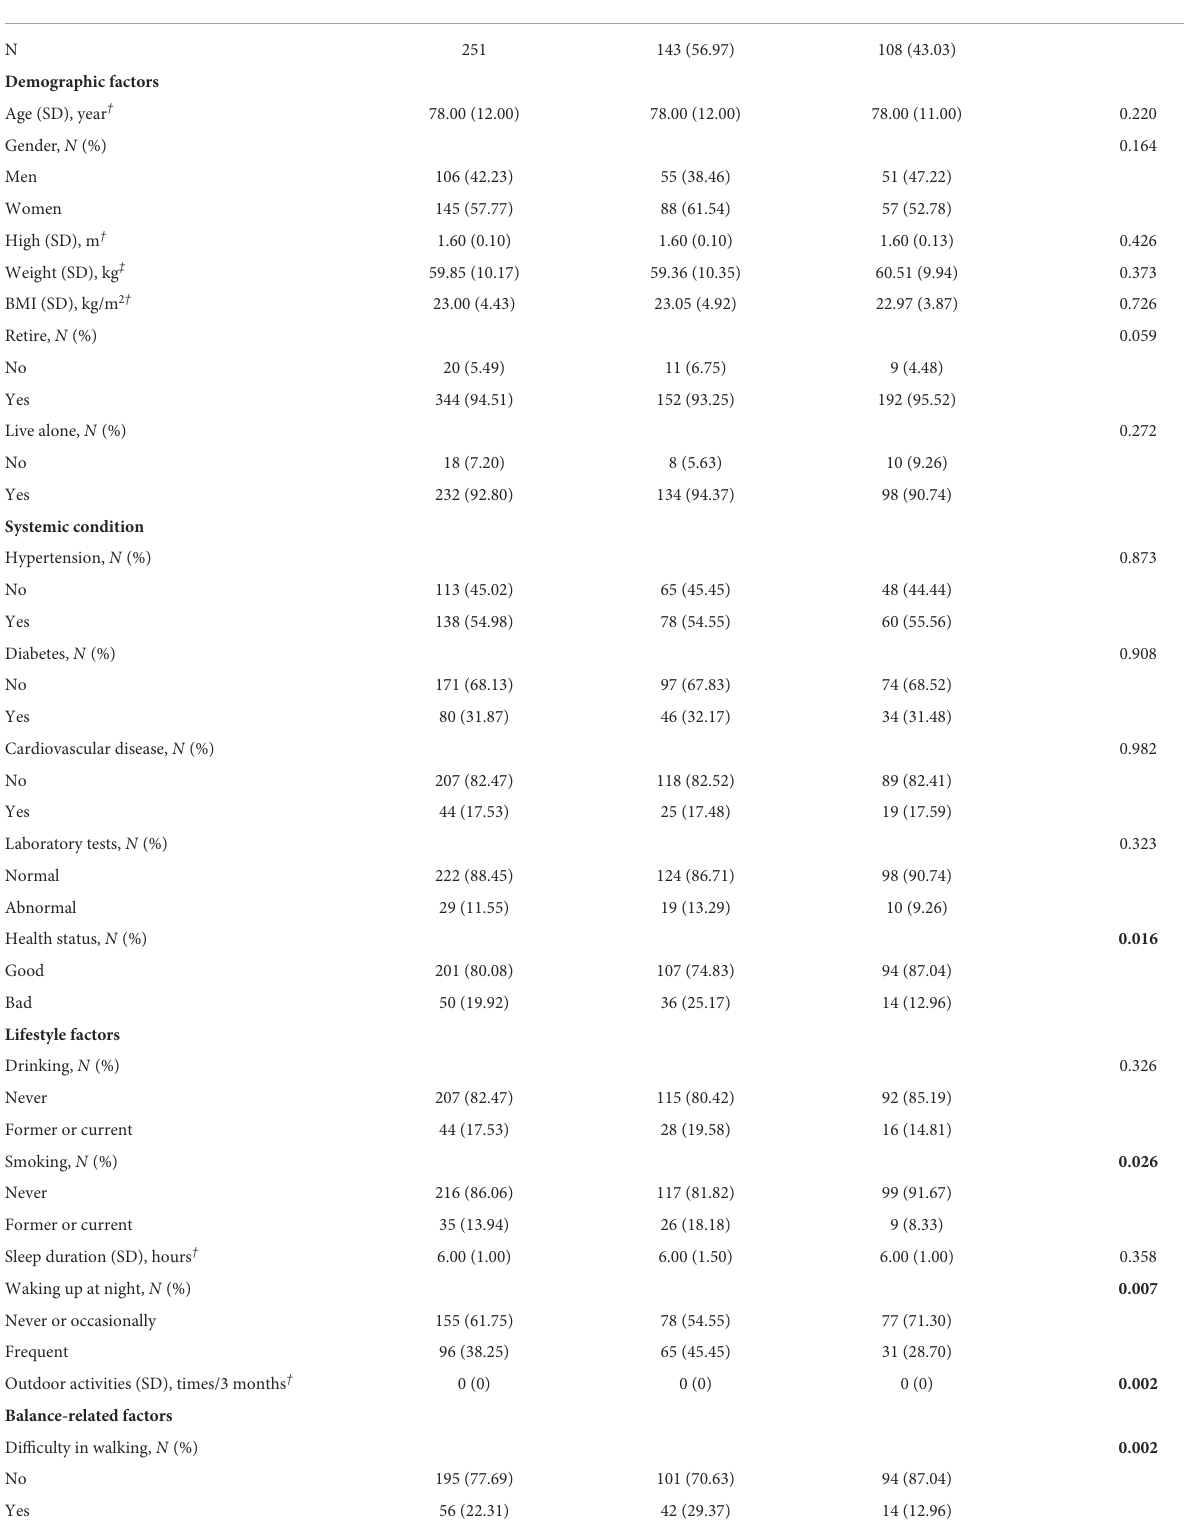
TABLE 1 Baseline characteristics stratified by fall status at